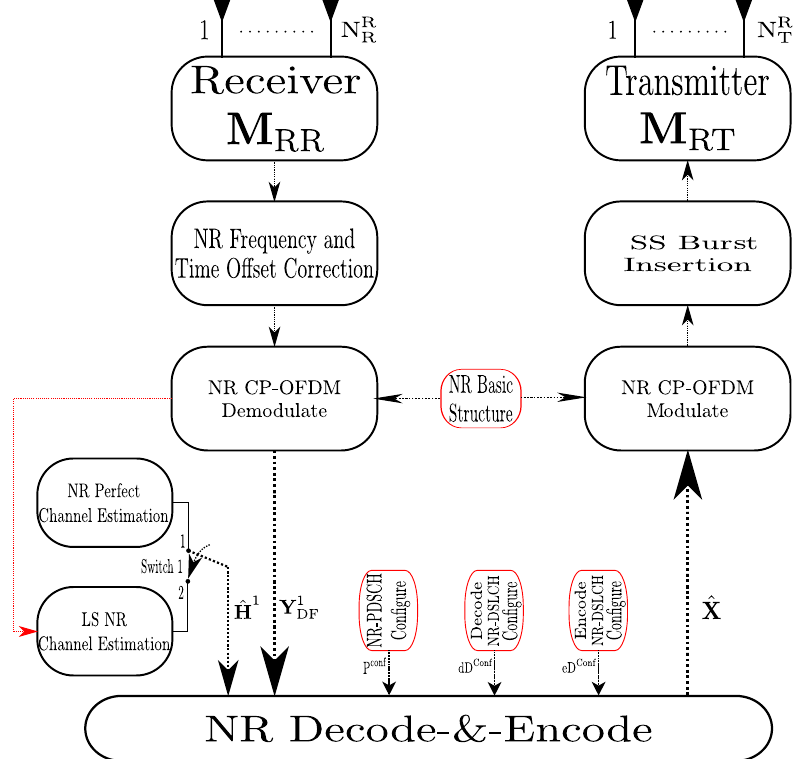
Figure 5. Decode-and-Forward (D&F) mmWave NR-RN processing